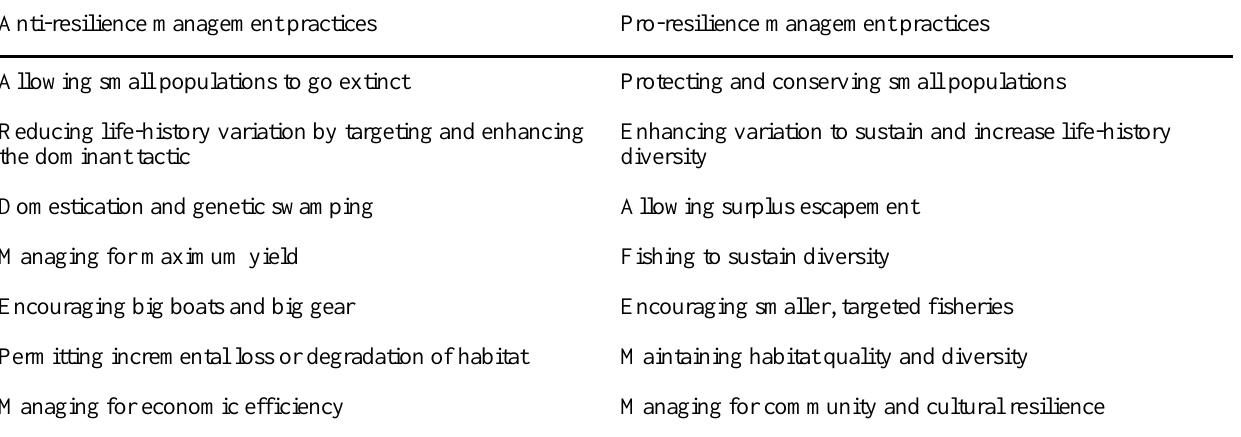
Table 2. Management practices that degrade or enhance salmon and fishery